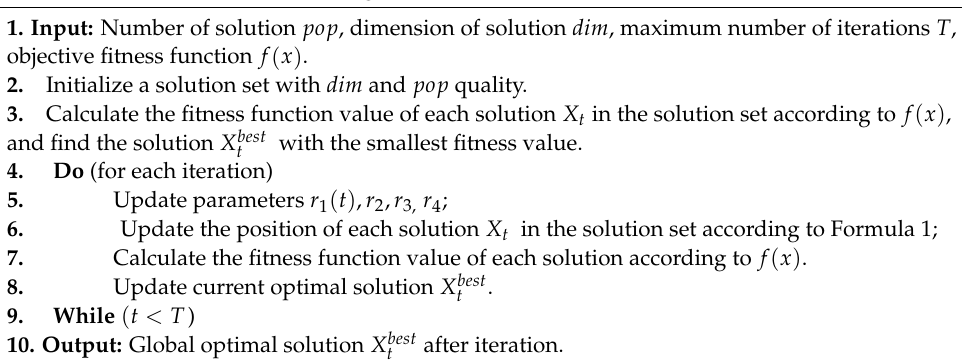
Algorithm 1 Standard sine cosine